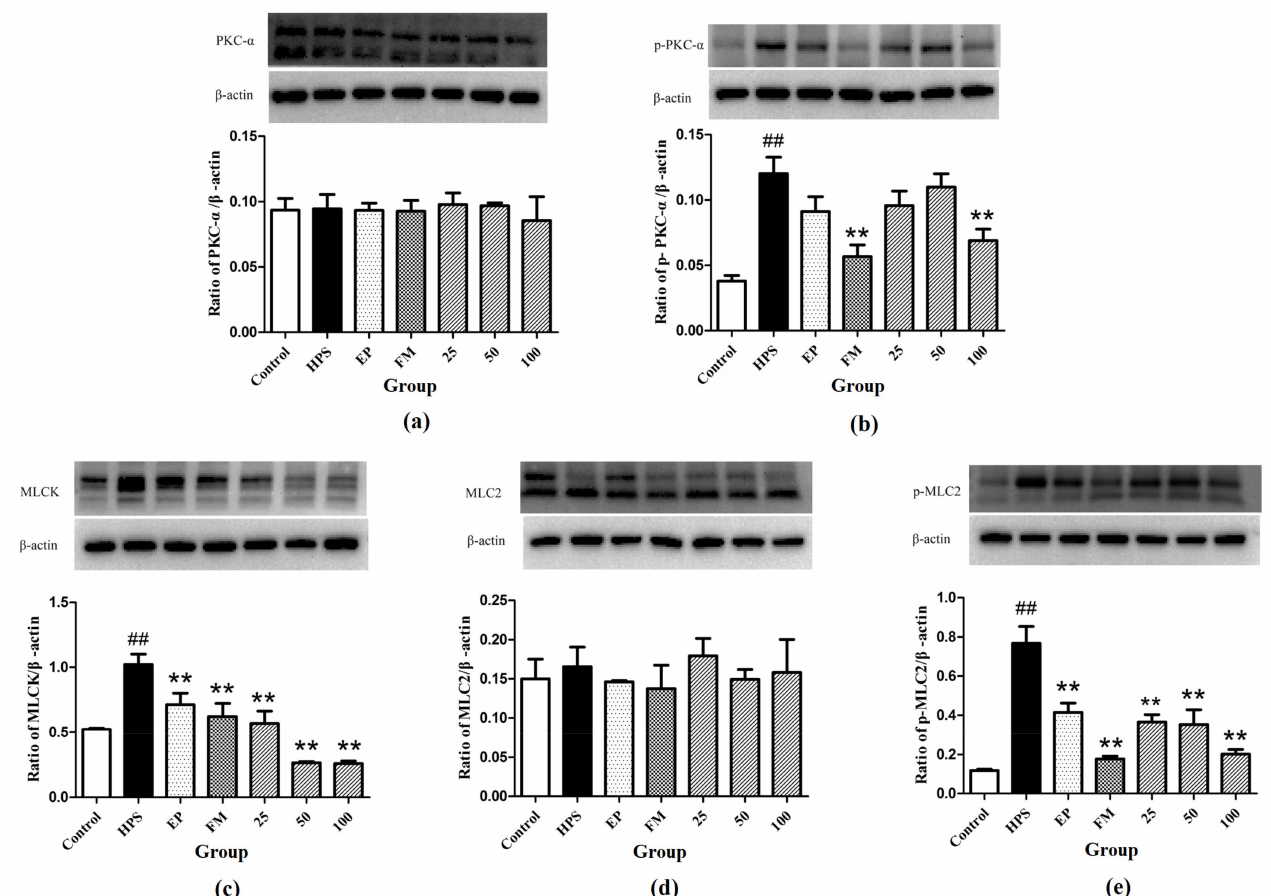
Figure 7. Inhibition effects of baicalin on PKC and MLCK/MLC signaling pathway in peritoneum activated by G. parasuis ( a ) PKC- α , ( b ) p-PKC- α , ( c ) MLCK, ( d ) MLC-2, ( e ) p-MLC-2 (Mean ± SD, n = 3). HPS: G. parasuis group, EP:EP + G. parasuis group, FM:FM + G. parasuis group, 25:25 mg/kg baicalin + G. parasuis group, 50:50 mg/kg baicalin + G. parasuis group, 100:100 mg/kg baicalin + G. parasuis group. ## p < 0.01 vs. control and ** p < 0.01 vs. G. parasuis